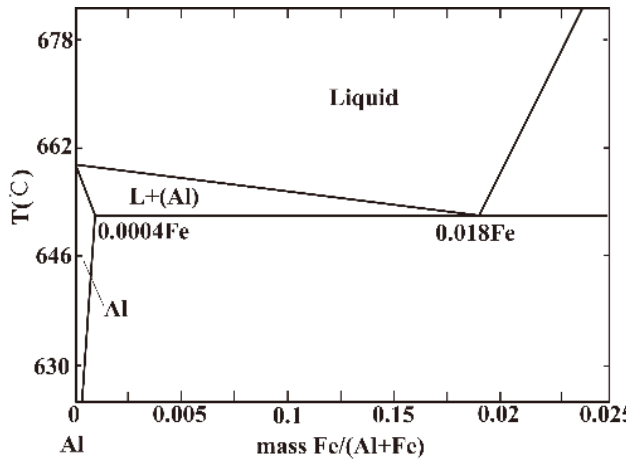
Metals 2018 , 8 , x FOR PEER REVIEW Figure 1. Al–Fe phase diagram calculated with FactSage™. Figure 1. Al–Fe phase diagram calculated with FactSage™.